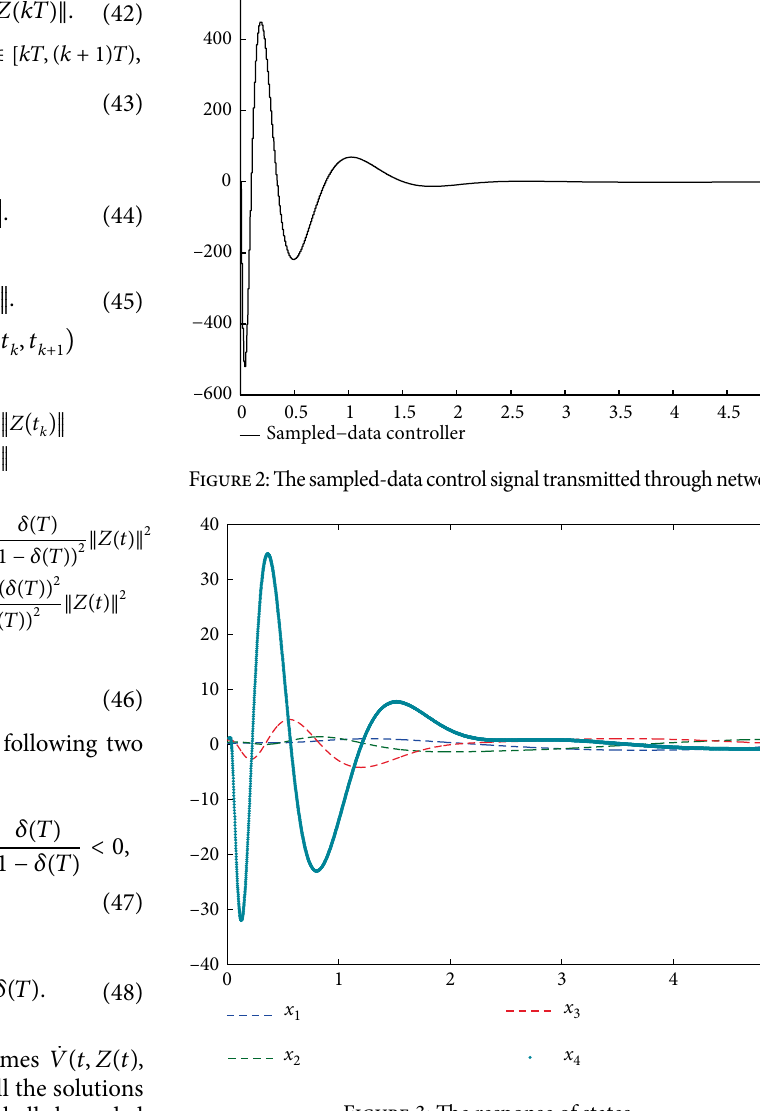
Figure 3: The response of